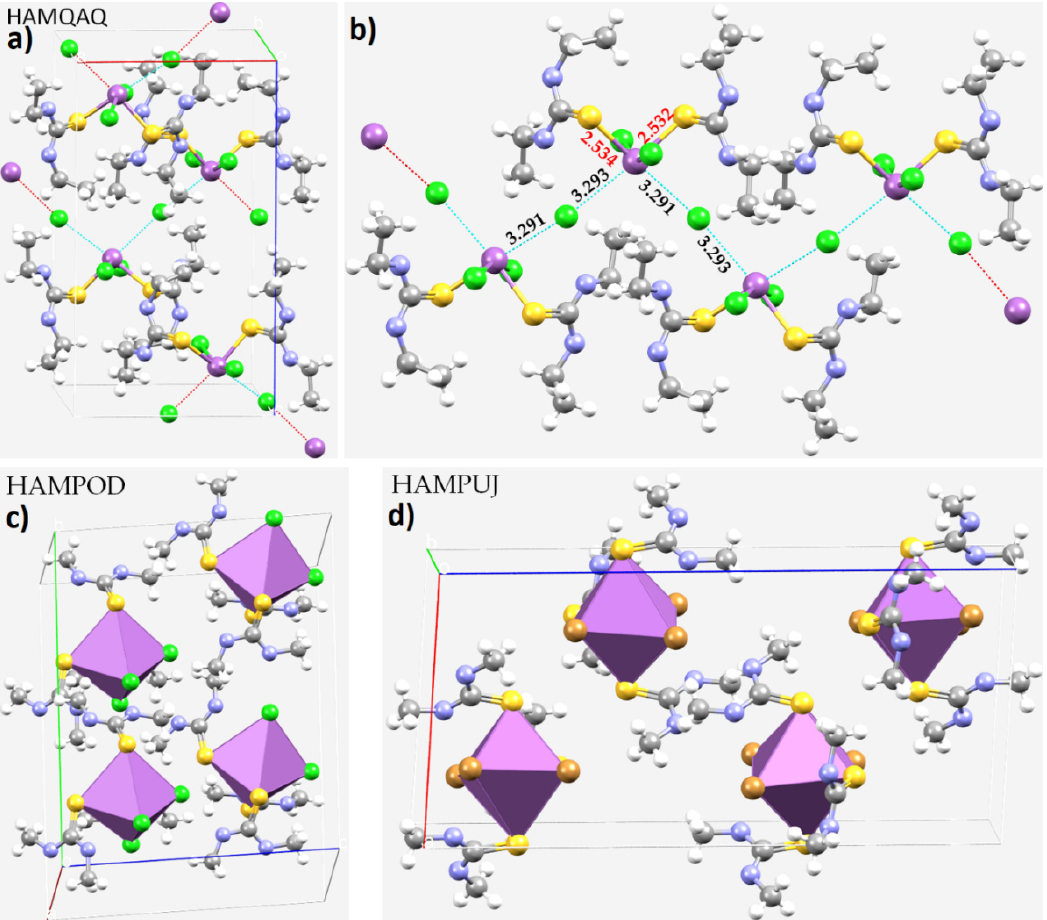
Figure 24. ( a ) The mixed polyhedral and ball-and-stick model of the unit-cell crystal structure of b,c,d-Cl-[SbCl 3 (DETU) 2 ]. ( b ) The nature of Sb···Cl zigzag array responsible in part for the packing of the entire crystal that extends along the crystalgraphic a -axis. The polyhedral models of the crystal structure of ( c ) fac -SbCl 3 (DMTU) 3 and ( d ) mer -SbBr 3 (DMTU) 3 ]. Selected bond lengths and bond angles in Å and degree, respectively. The CSD ref. code is shown for each case. The polyhedra represent to a six-coordinate Sb, and atoms are shown as small spheres and bonds as lines in atom color, whereas the intermolecular interactions are represented by dotted lines. In fac -SbCl 3 (DMTU) 3 and mer -SbBr 3 (DMTU) 3 (Figure 24c and 24d, respectively), there are three Sb–S and three Sb ‒ X (X = Cl, Br) bonds. There are also long Sb···X contacts (one r (Sb···Cl) = 3.011 Å in fac -SbCl 3 (DMTU) 3 and two r (Sb···Br) = 3.006 and 3.180 Å contacts in mer -SbBr 3 (DMTU) 3 .